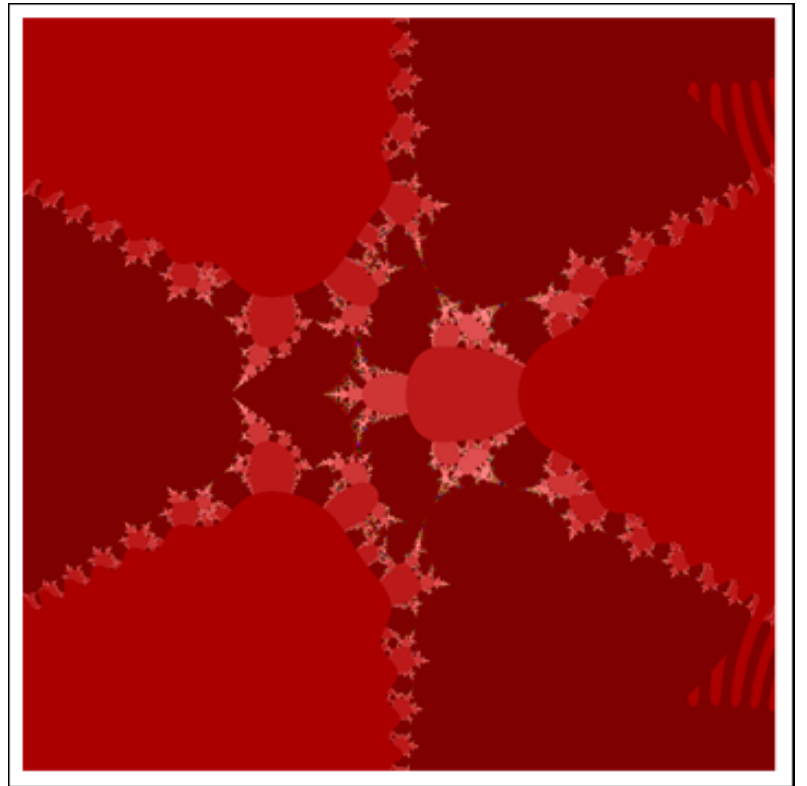
Figure 32. M-set for τ ( z ) = e z 3 + c via DKIS. The image execution time is 885.515 s.